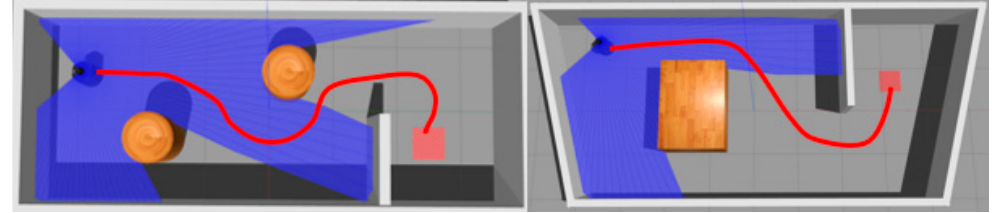
Figure 11. Model path.